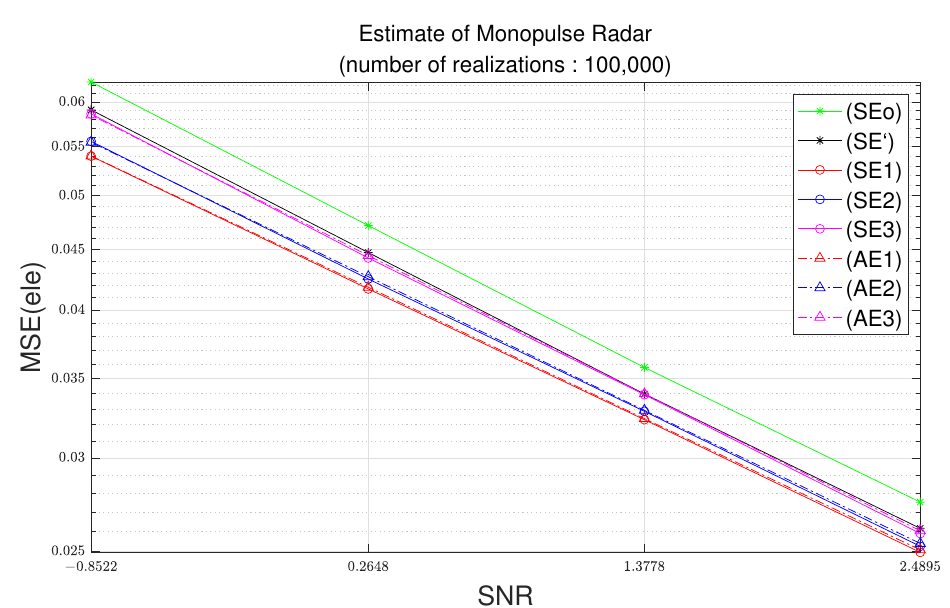
Figure 10. Elevation MSE as function of SNR with parameters of Table 2 and 100,000 realizations. Table 4. MSE error expression